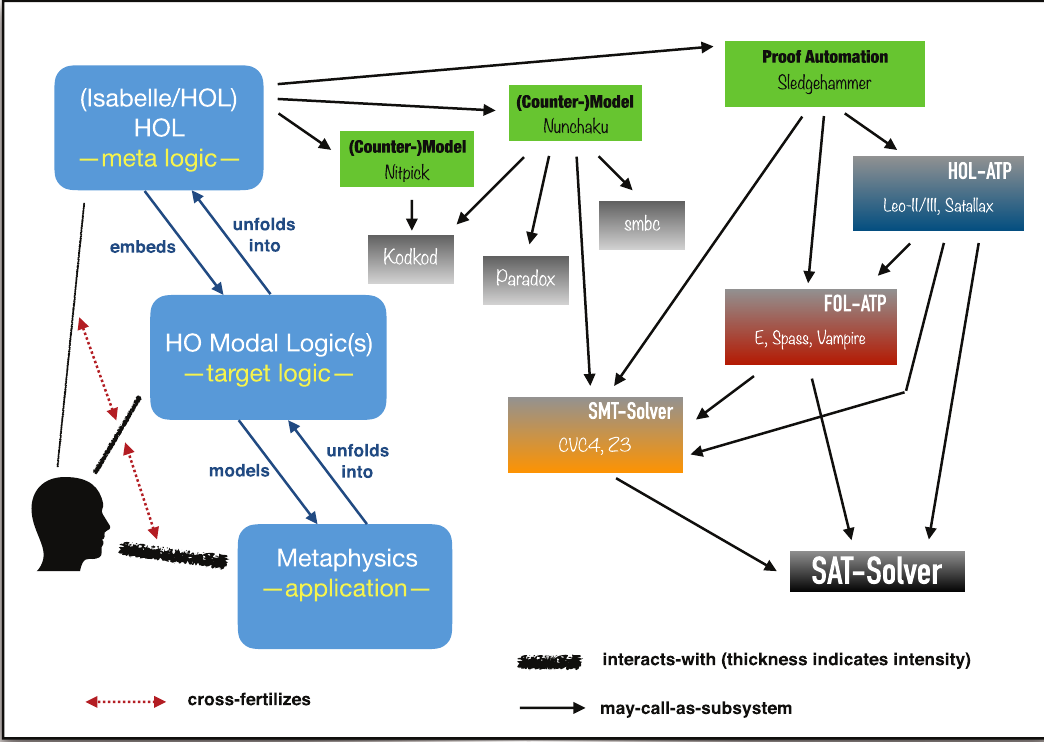
Figure 3: Our general methodology supports the reuse of state of the art theorem proving